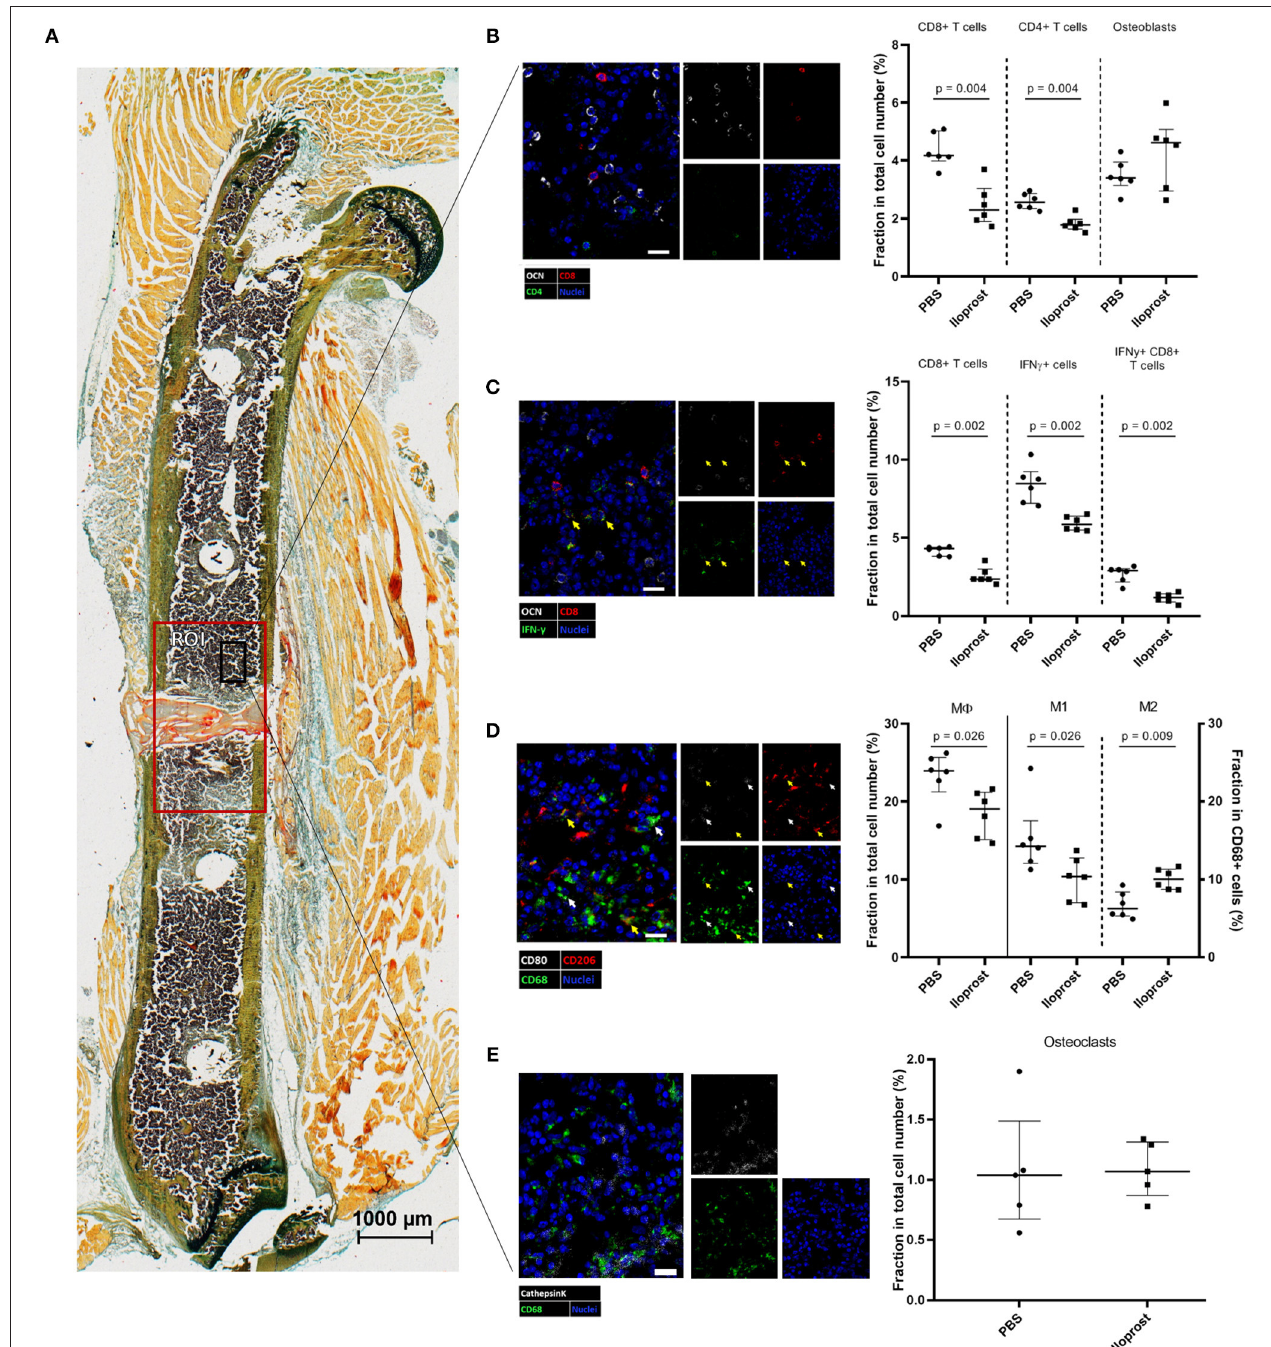
FIGURE 11 | Immunohistochemical (IHC) analysis of the distribution of immune cells in the fracture zone 3 days post-osteotomy. (A) A section of a fractured femur from the Iloprost treated group is displayed, Movat Pentachrome staining. The region of interest (ROI) for the quantitative analysis of IHC images is enlarged (red rectangle). The black rectangle represents the region from which the representative examples of the respective IHC staining for (B) CD4 + and CD8 + T cells and osteoblasts, (C) IFN γ producing CD8 + T cells; CD8 + IFN γ + cells = white indicator, (D) macrophages; M1-type macrophages = white indicator; M2-type macrophages = yellow indicator, and (E) osteoclasts were taken. The quantification of the cellular distributions are displayed in the corresponding dot plot graphs. Color code: Movat Pentachrome mineralized bone = yellow, cartilage = dark blue-green, connective tissue = light blue-green, muscle fibers = light orange, cell nuclei = purple, fibrin clot = red/orange; (B) osteoblasts = white, CD8 + T cells = red, CD4 + T cells = green and cell nuclei = blue; (C) osteoblasts = white, CD8 + T cells = red, IFN γ = green, cell nuclei = blue; (D) CD68 = green, CD80 = white, CD206 = red; (E) osteoclasts: double positive for cathepsinK = white and CD68 = green cell nuclei = blue. Scale bars: 20 µ m (IHC) 1,000 µ m (Movat Pentachrome); n = 6.